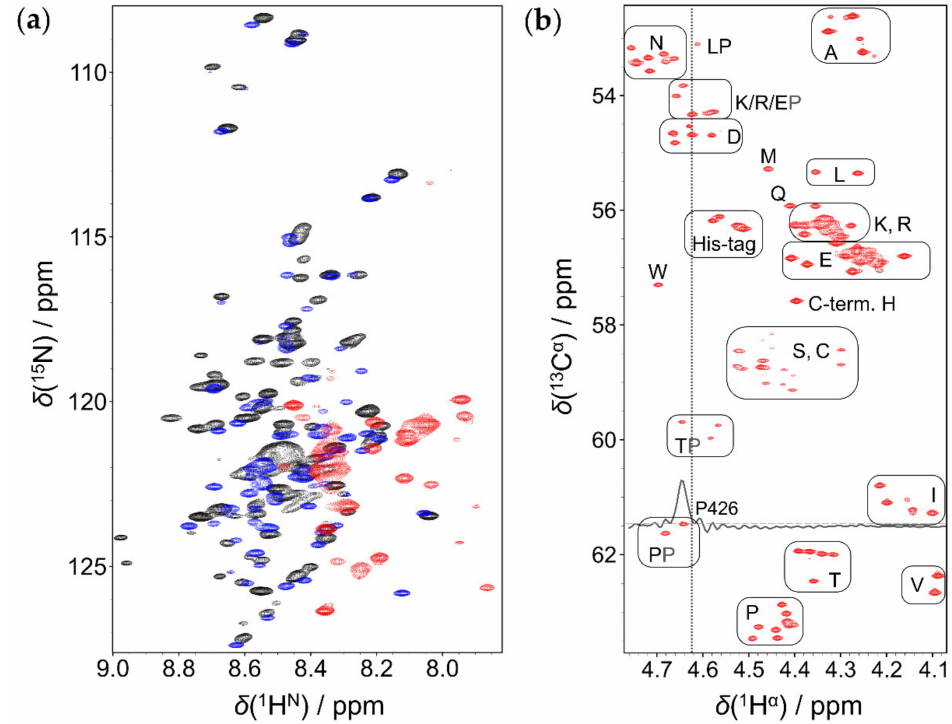
Figure 2. Comparison of 1 H N and 1 H α detected methods: ( a ) 1 H, 15 N-HSQC at 310 K, pH = 7.2 (red), at 278 K, pH 7.2 (blue), and 278 K, pH = 5.1 (black). ( b ) SHACA-HSQC at 310 K, pH = 7.2. Amino acid types are shown with boxes (except glycines), the residual water signal is indicated with a light grey dashed line at 4.62 ppm. 1D row at δ C α = 61.47 ppm is shown to illustrate sensitivity for Pro426 in the proximity of the residual water